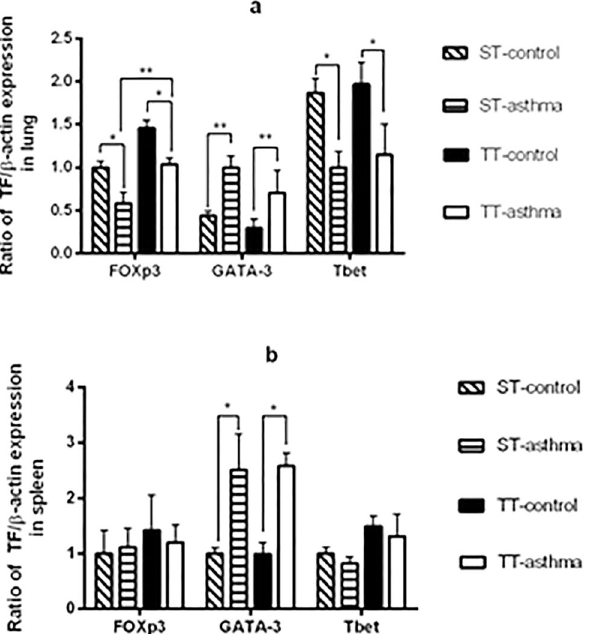
Figure 4. Effects of ambient temperature on Foxp3, T-bet, and GATA3 expression in the lung and spleen. The mRNA expression of Foxp3, T-bet, and GATA3 in the lung tissue ( a ) and spleen tissue ( b ) were detected by RT-PCR. ST: standard temperature (20 °C); TT: thermoneutral temperature (30 °C). The data presented are mean ± SEM. * denotes P < 0.05, ** denotes P < 0.01 (n = 6 mice per